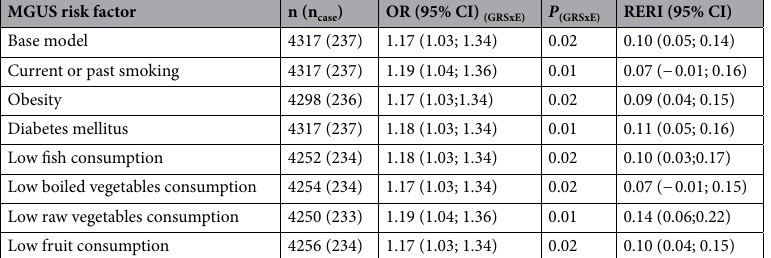
Table 5. Changes in the interaction effect of the genetic effect (GRS MGUS2017 ) by dichotomised education (E) on MGUS (base model) in separate sex-and age-adjusted logistic regression models additionally including the main effects and respective interaction terms for each potential risk factor (odds ratios, OR; 95% confidence intervals, 95% CI; relative excess risk due to interaction, RERI).